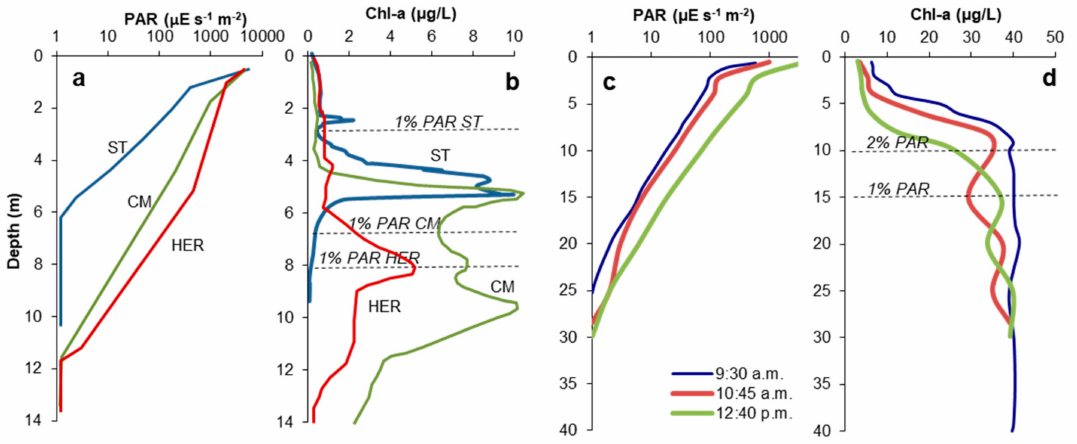
Figure4. ( a , b )ComparisonofrepresentativesummerprofilesofPAR( a )andchlorophyll-aconcentration ( b ) in the APL of Cueva de la Mora (CM), Herrer í as-Guadiana (HER) and San Telmo (ST) (all of them were taken in July 2011). ( c , d ) Diurnal variation of PAR ( c ) and Chl-a concentration ( d ) in Barruecopardo, as measured in January, 2008. 1% PAR = depth at which PAR is 1% of the lake